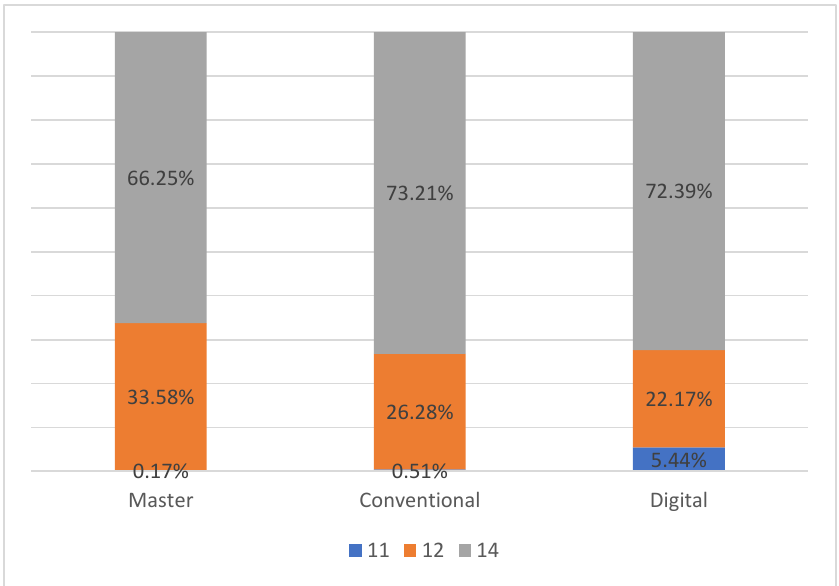
Figure 4. Occlusal contact surface area (pixels) post image processing. * Asterisk indicates statisti- cal significance of p < 0.001.